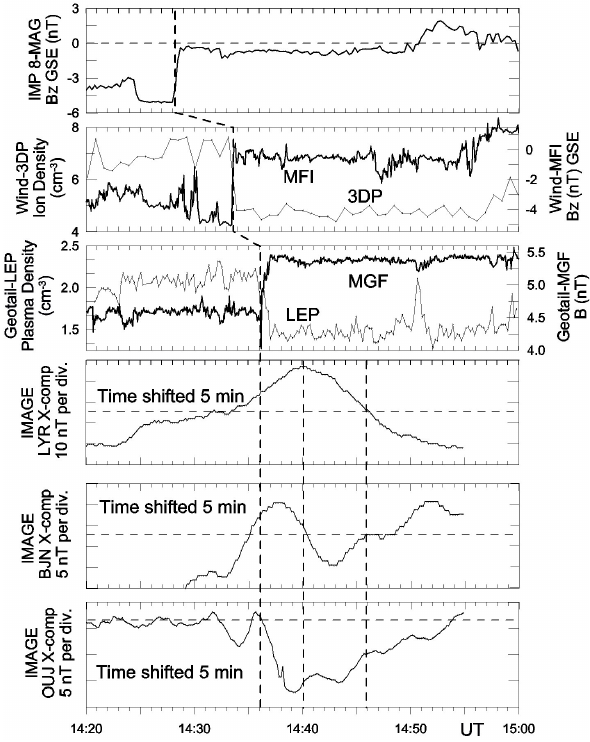
Fig. 9. Stepwise drop in solar wind pressure (vertical dashed line) identified along the magnetic field and particle density traces of data obtained by IMP 8 (top panel), Wind (second panel) and Geotail (third panel). The monopolar (positive in LYR station, negative in OUJ) and bipolar (PN-type in BJN) ground signatures associated with the pressure variation are displayed in the three bottom